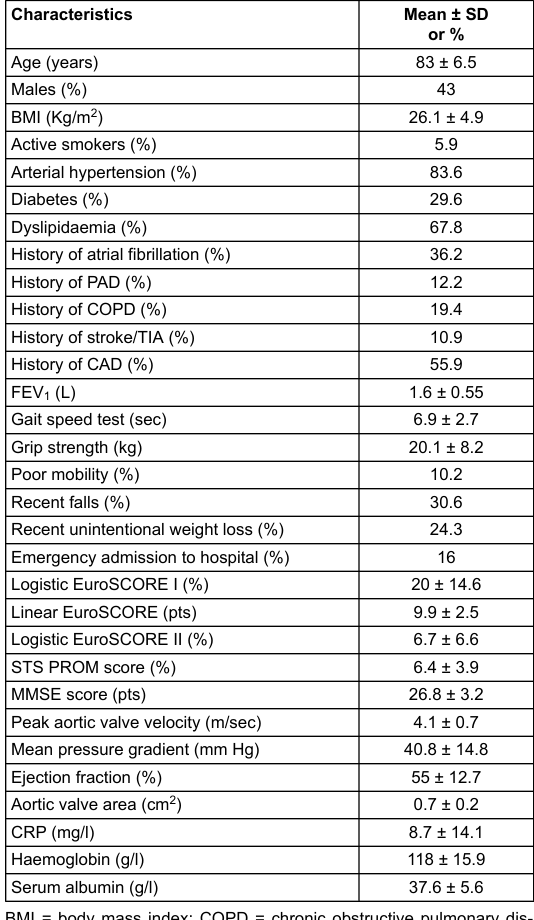
Table 1: Baseline characteristics of the study population. Characteristics